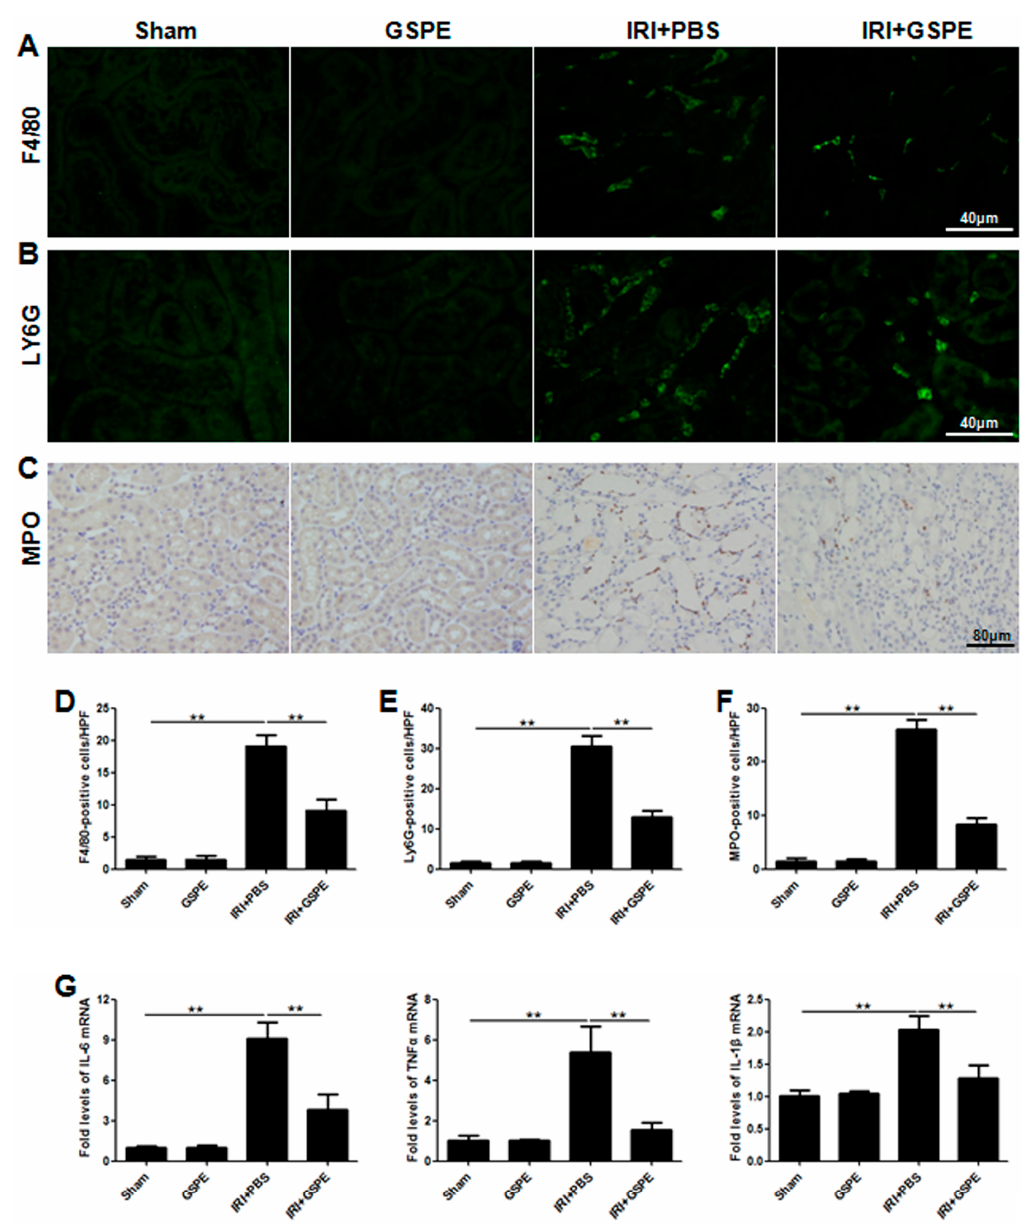
Figure 2. Pretreatment with GSPE attenuates the IR-induced inflammatory reaction. ( A ) Immunofluorescence staining of F4/80 was performed to analyze the infiltration of macrophages; ( B ) Ly6G staining was performed to assess the number of neutrophils; ( C ) Immunohistochemistry staining of MPO was performed to calculate the neutrophil infiltration; ( D – F ) Semi-quantitative assessment of F4/80, Ly6G and MPO staining; ( G ) Real-time PCR of IL-6, TNF- α and IL-1 β was performed to evaluate the expression level of inflammatory cytokines in the kidney. The data shown are mean ± SEM (** p < 0.01; n = 7 per group).